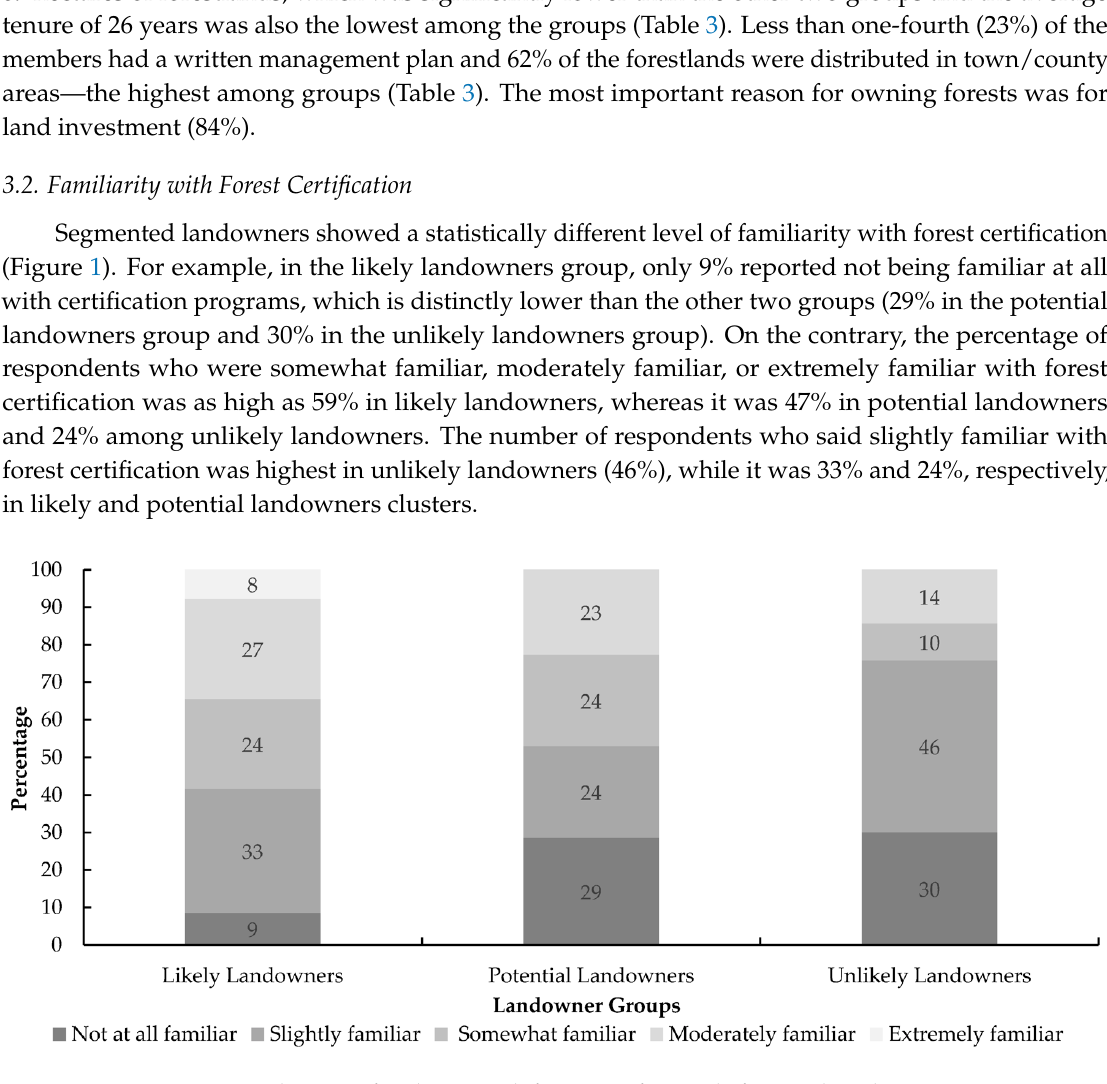
Figure 1. Landowners’ familiarity with forest certification before reading the survey.